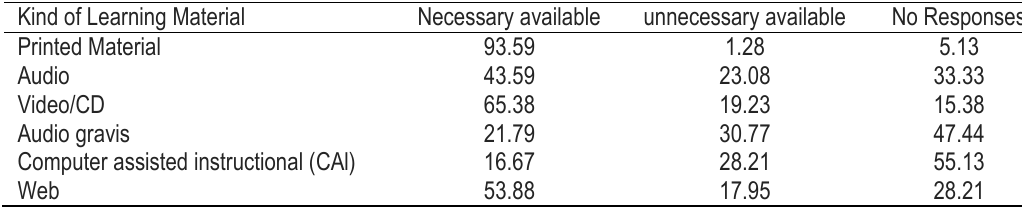
Table 3: Response about whether or not the Distance Higher Education Kind of Learning Material Necessary available unnecessary